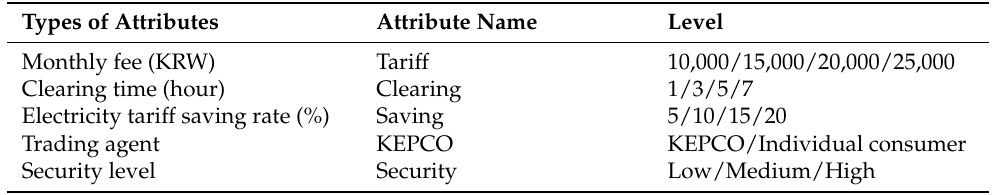
Table 2. Attributes and Levels in Choice